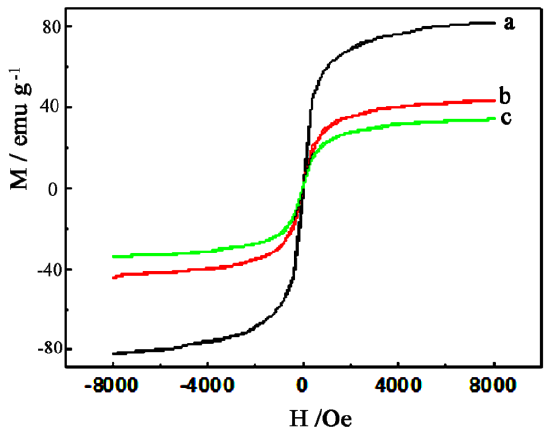
Figure 5. Dependence of magnetization on the applied magnetic field at room temperature for samples: a, γ-Fe 2 O 3 ; b, γ-Fe 2 O 3 /PANI and c, γ- Fe 2 O 3 /PANI/curcumin.